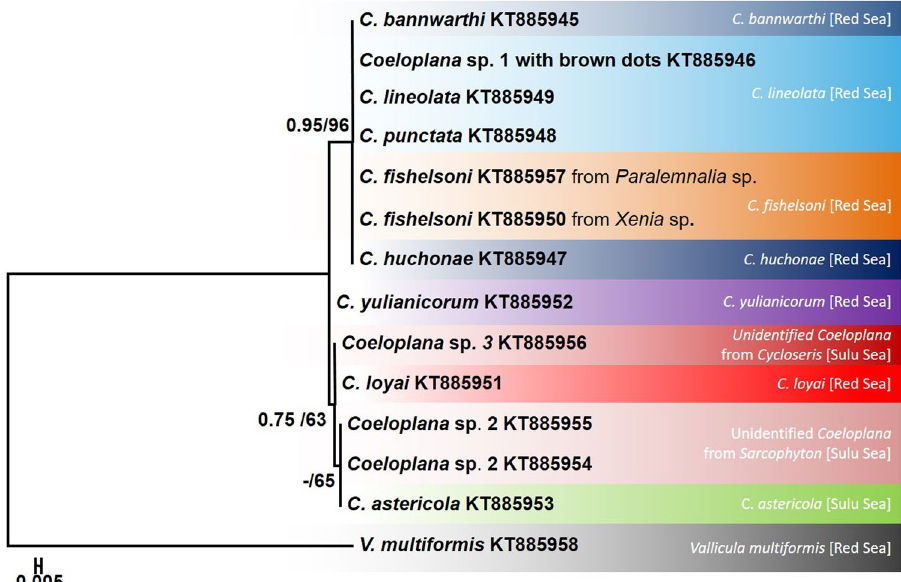
Figure 2. 28S rDNA maximum likelihood tree. The phylogenetic reconstruction was based on 721 bp from the C1-D2 domain of the 28S rDNA gene. ML bootstrap support/Bayesian posterior probabilities are indicated near the corresponding nodes. All sequences were generated in the framework of this study. Coeloplanidae species considered valid based on the COI analysis are indicated by different colors.